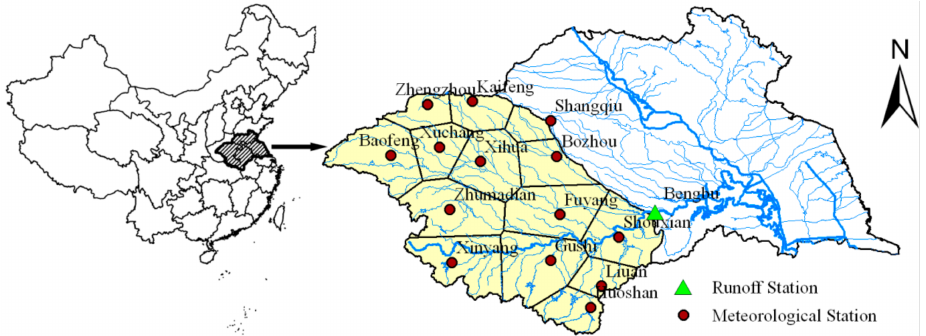
Figure 1. Distribution of meteorological stations, runoff station and Thiessen polygons in the upper Huai River basin. Figure adapted from Duan et al.